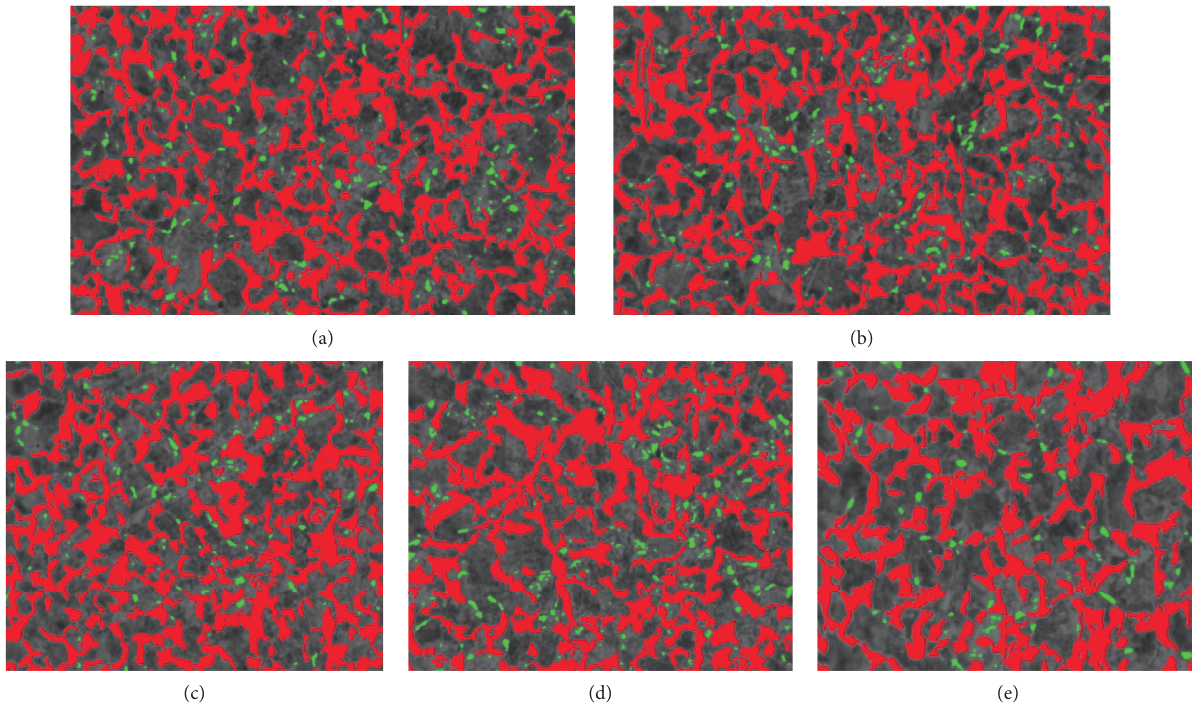
Figure 21: Quantitative analysis of structural elements during air cooling in the field of view. № 1—the concentration of excess ferrite is 28.8504% (a); № 2— excess ferrite concentration of 29.9103% (b); № 3—excess ferrite concentration of 31.2454% (c); № 4— excess ferrite concentration of 31.4373% (d); № 5—the concentration of excess ferrite is 28.5952% (e) ( ×